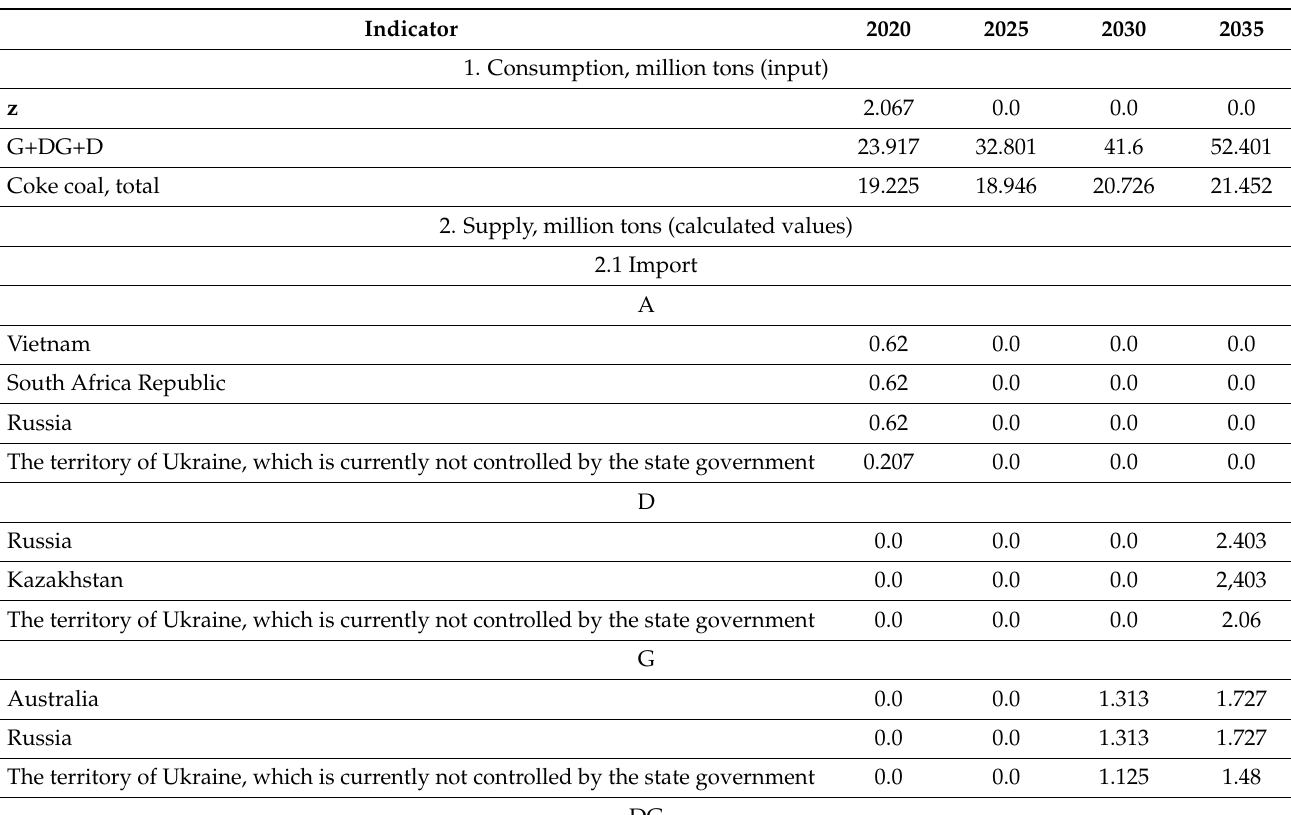
Table 3. The results of calculations of coal balances for the period up to